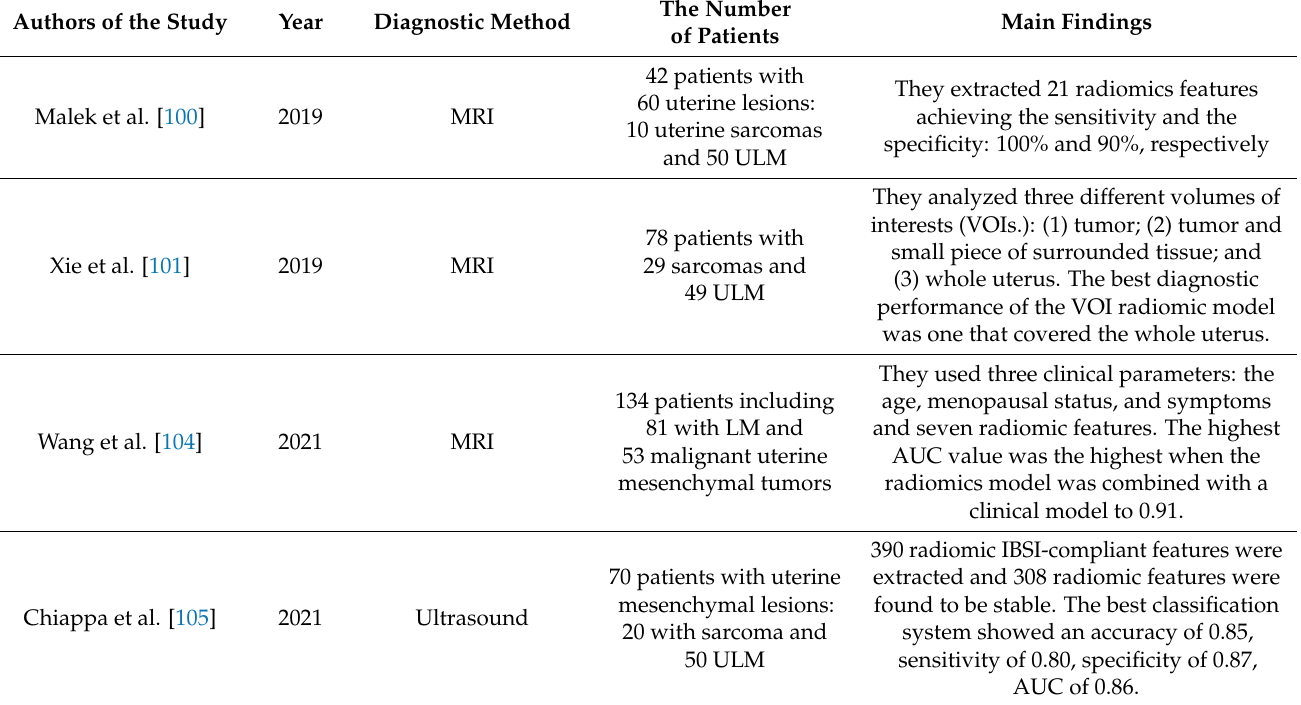
Table 4. Radiomics in uterine masses